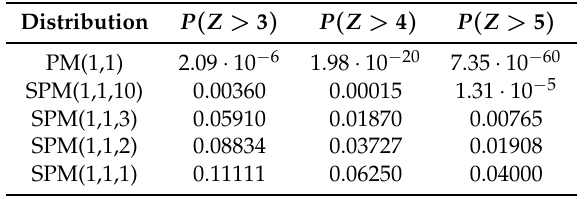
Table 1. Tails comparison for different SPM and PM distributions.